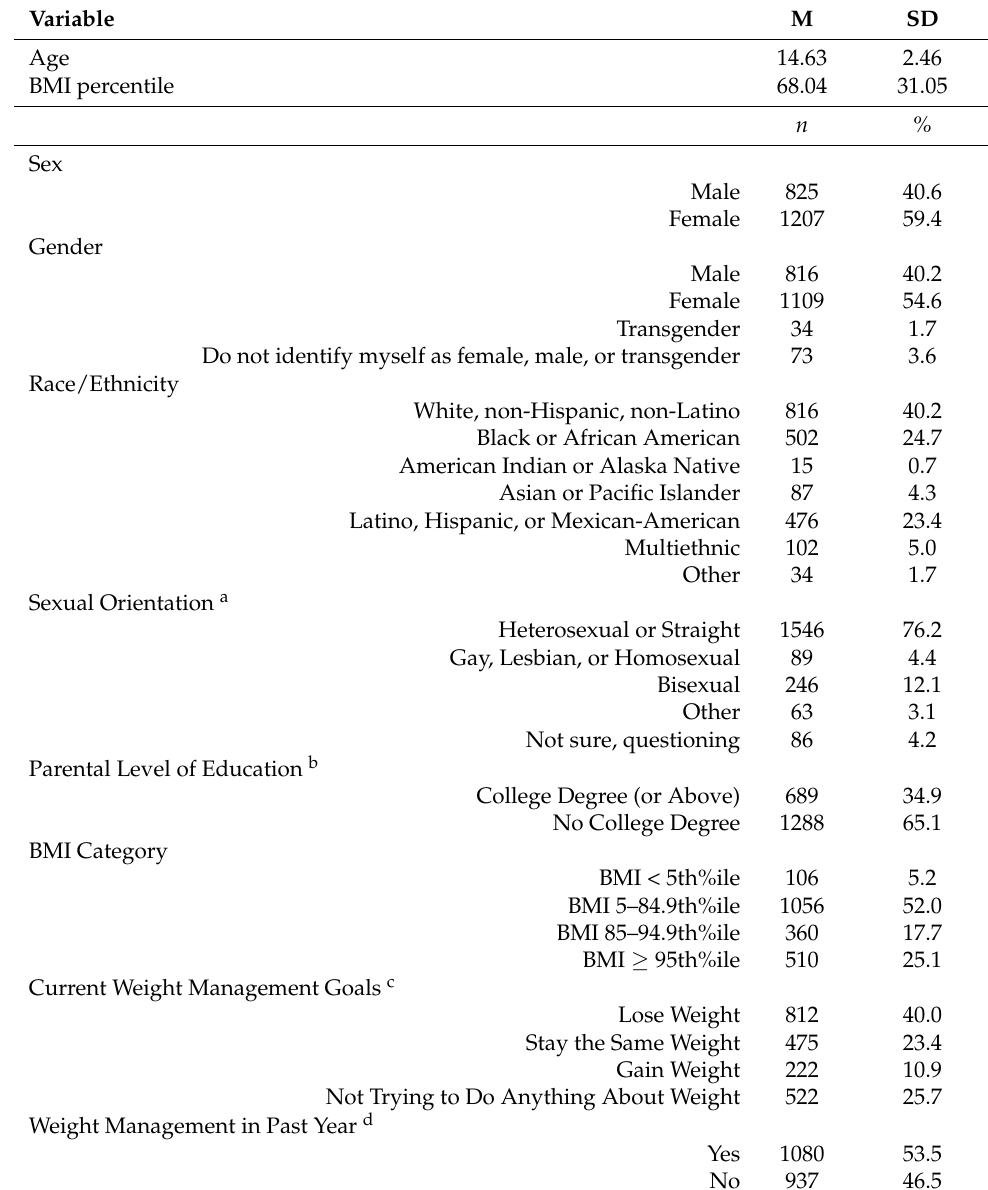
Table 2. Demographic and anthropometric information for the adolescent sample ( n =